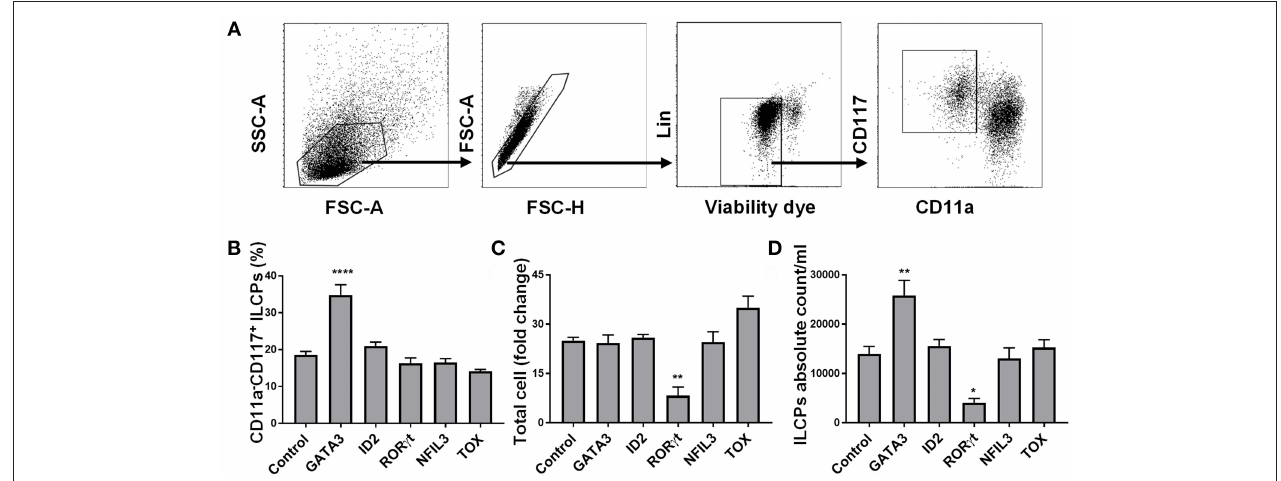
FIGURE 1 | GATA3 but not ID2, ROR γ t, NFIL3, or TOX influences the differentiation of ILCs from HSCs. Five-day expanded UCB CD34 + HSCs were transfected with either GATA3, ID2, RORC, NFIL3, TOX or scrambled control mRNAs and differentiated under conditions that favor ILCPs development. (A) Gating strategy of ILCPs, 14-days differentiating HSCs. (B) Differentiating HSCs were stained for the surface CD11a and CD117 at day 14 post electroporation and the percentage of CD117 + CD11a − ILCPs is shown in bar graph ( n = 4/group). (C) Total counts of differentiating HSCs were performed at day 14 of culture and fold change is depicted ( n = 4/group). (D) Absolute counts of CD117 + CD11a − ILCPs in 1mL of culture media is depicted ( n = 4/group). (B–D) Data are shown as mean ± SD, One-way ANOVA and significance comparing to the control is shown (* p < 0.01; ** p < 0.001; **** p < 0.0001).